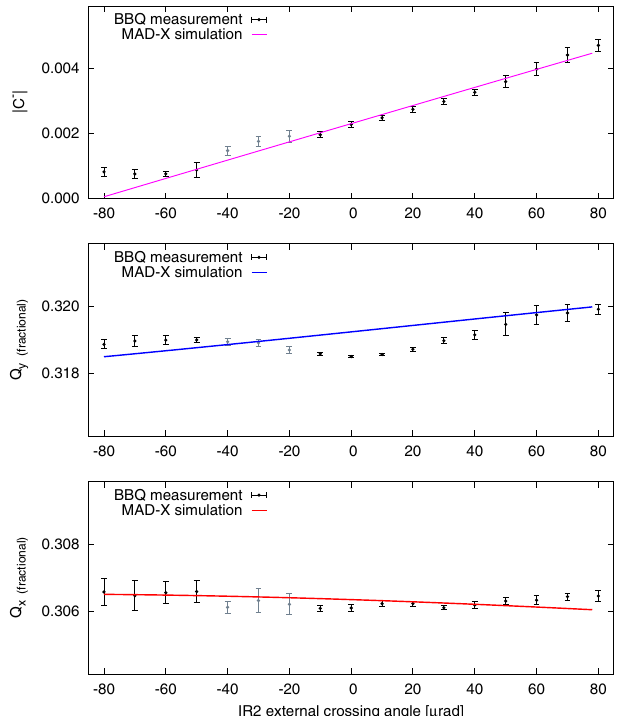
FIG. 4. Modeled and measured tunes and coupling of LHC ¼ 1 m, plotted versus the external crossing angle. beam 1 at β (cid:1) IP 2 The model has been matched to produce zero coupling at the crossing angles corresponding with the projected minimum of the observed j C − j variation. Gray points indicate data where the BBQ measurement was apparently influenced by the LHC chirp in a way which is neither normally observed in the LHC nor